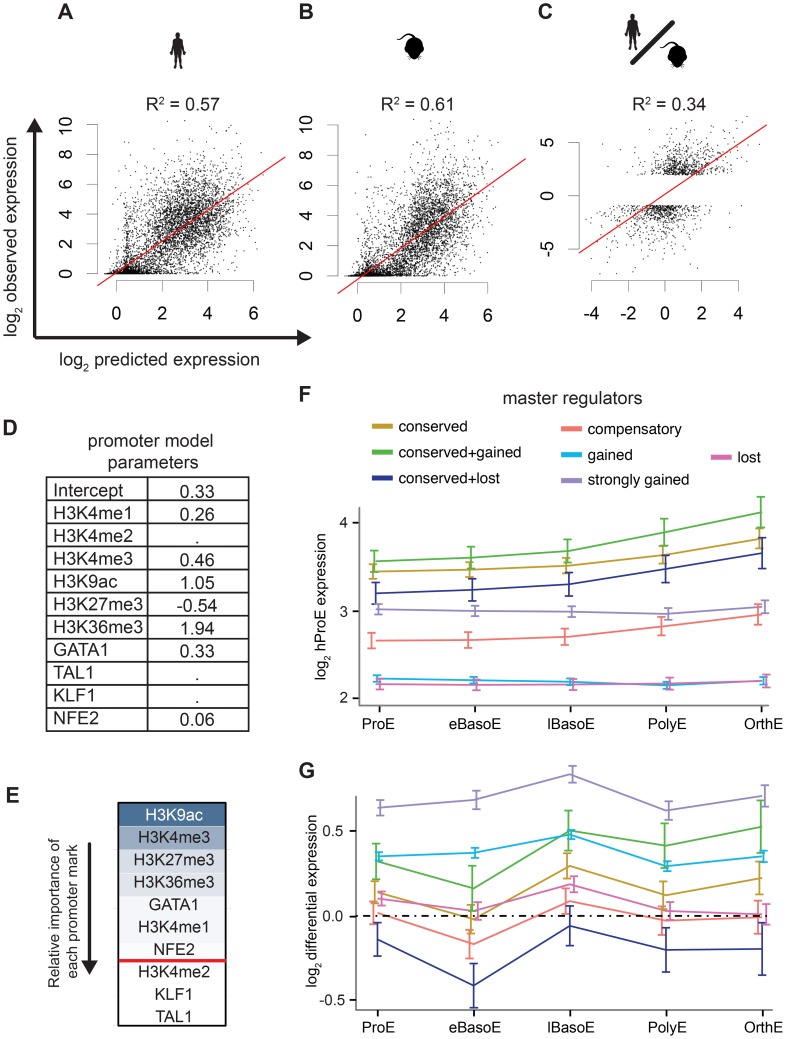
Predictive models of gene expression across species.A)–C) The y-axis is observed values and the x-axis is predicted values. R2 values are reported from each consensus model where the lambda “penalty” value is cross-validated ten times and chosen as 1 standard error below the best to prevent over fitting. A) Consensus model predictions from mouse ProE epigenomic marks predict mouse ProE gene expression. B) Consensus model predictions from human ProE epigenomic marks predict human ProE gene expression. C) Applying the consensus model to the difference of human and mouse epigenomic marks is predictive of differences in transcription between the species. D) Coefficients for each retained variable for consensus model (top of A)). E) Relative importance of each epigenomic mark in the consensus model based upon scaled coefficients in the consensus model (un-scaled coefficients are shown in D). F) Gene expression patterns during terminal erythroid differentiation based upon proximity to TF occupancy sites for varying TF occupancy conservation (defined in Fig. 4B–F) across all TFs. G) Similar to F), except shown for changes in gene expression between the two species (human-specific genes correspond to positive values). Abbreviations used: ProEs, pro-erythroblasts; eBasoE, early basophilic erythroblasts; BasoE, basophilic erythroblasts; lBasoE, late basophilic erythroblasts; PolyE, polychromatic erythroblasts; OrthE, orthochromatic erythroblasts; FPKM, fragments of aligned reads per kilobase of transcript per million mapped reads.